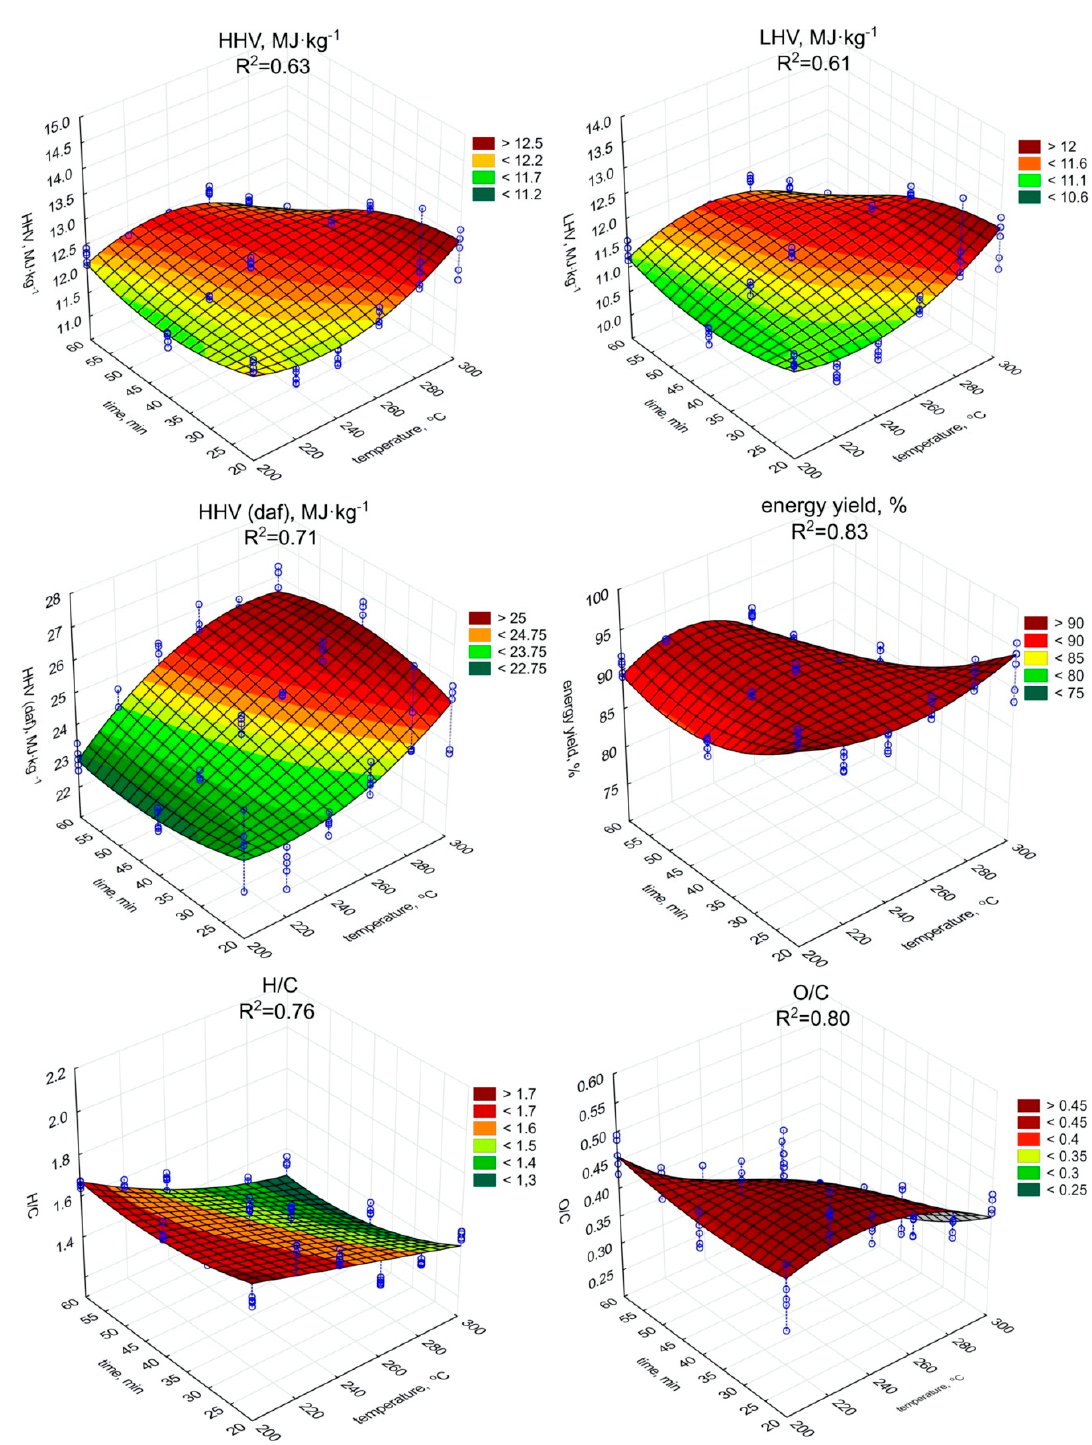
Figure 2. HHV, LHV, HHV daf., energy yield, and H/C, O/C molar ratios of torrefied SS in relation to process temperature, and residence time.